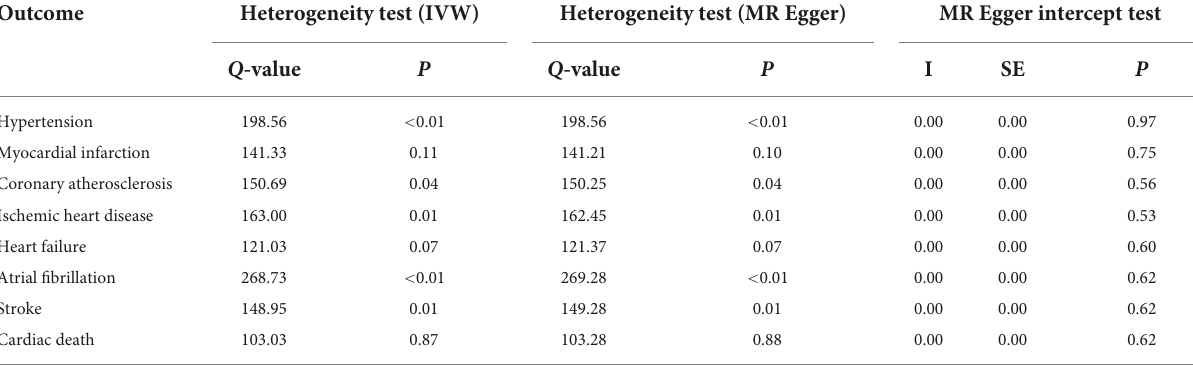
TABLE 3 Heterogeneity and horizontal pleiotropy of the associations between telomere length (TL) and cardiovascular diseases (CVDs). Outcome Heterogeneity test